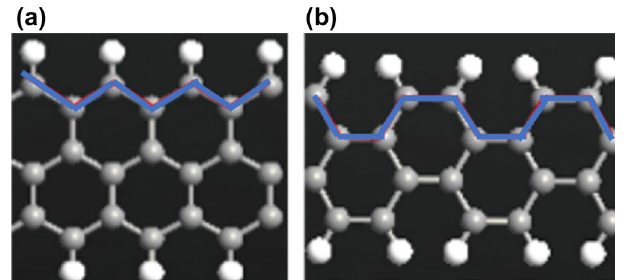
Figure 2. Graphene nanoribbons types. ( a ) Zigzag nanoribbon ( b ) armchair nanoribbon. Produced by QuantumATK software (version 2018.06).